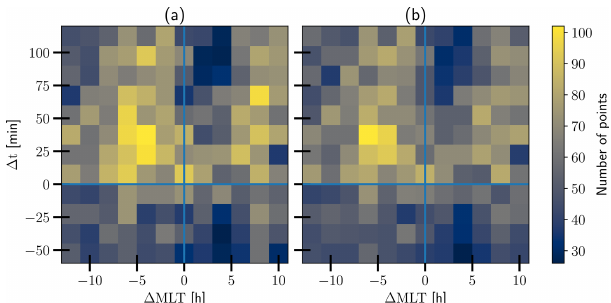
Figure 3. The number of Swarm oval crossings in each bin for the WEJ (a) , corresponding to panels a and c in Fig. 4, and for the EEJ (b) , corresponding to panels b and d in Fig. 4. (cid:49) MLT is the magnetic local time distance to the onset, and (cid:49)t is the temporal distance to the onset.